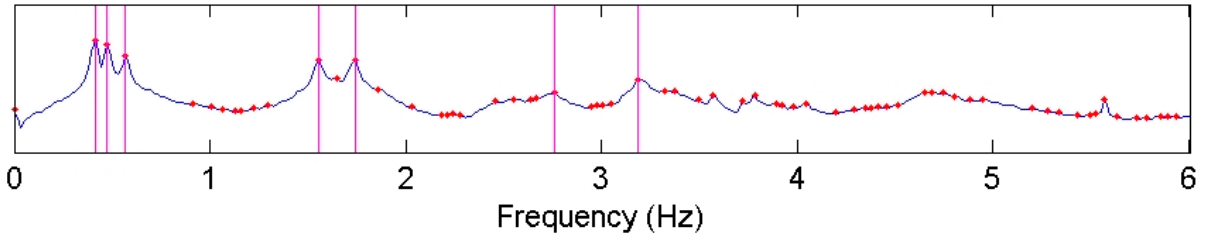
Figure 21. Plot of first singular values showing seven identified frequencies.